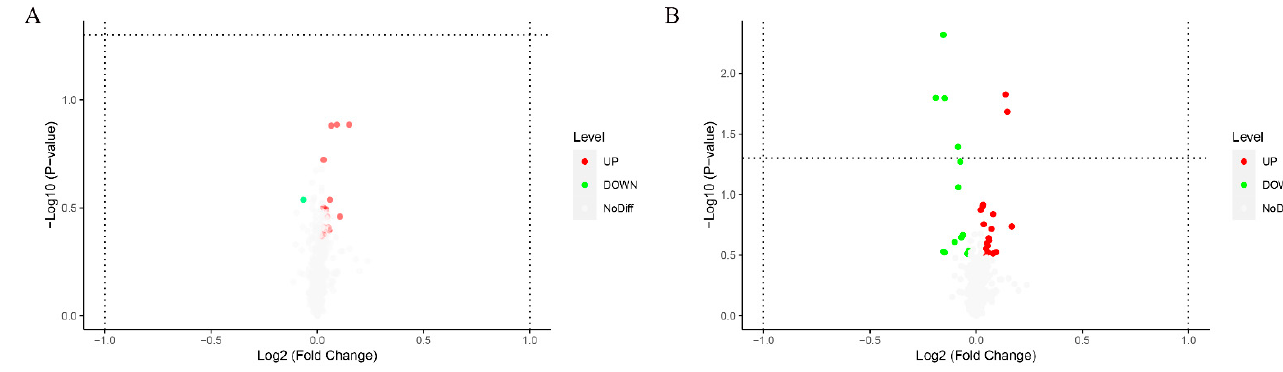
Figure 7. Classification analysis of differential metabolites based on KEGG database ( A ) and HMDB database ( B ). 2.5. Kyoto Encyclopedia of Genes and Genomes’ Functional Pathways To explore the potential pathways of differential metabolites, metabolic pathway en- richment analysis was performed based on the KEGG database under positive and nega- tive ion modes (Figure 8). Copper stimulation significantly affected arachidonic acid me- tabolism and alanine, aspartate and glutamate metabolism.